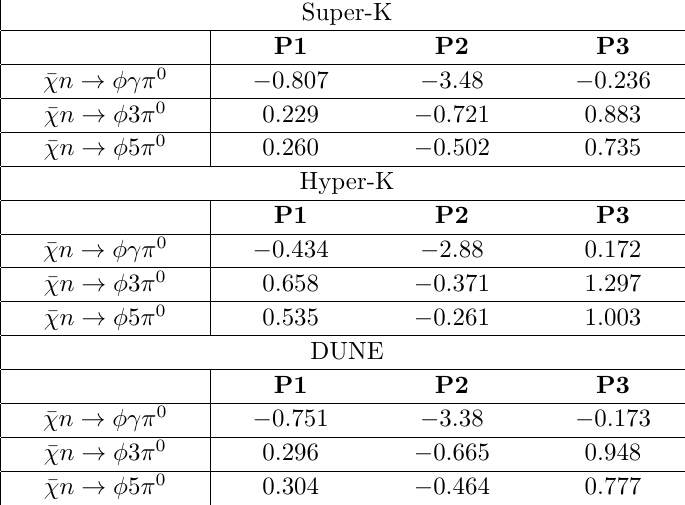
Table 4 . The minimum value of y for Model II that produces a signal event number within the 3 (cid:27) range in table 2; the maximum value (which gives 0 events) is y = 1 . Here kinematic cut-1 is